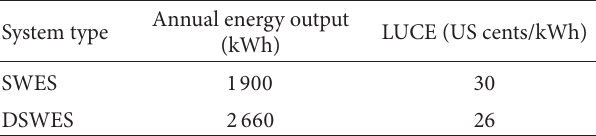
Table 2: Base values used for the comparison of the LUCE of the DSWES and the SWES.